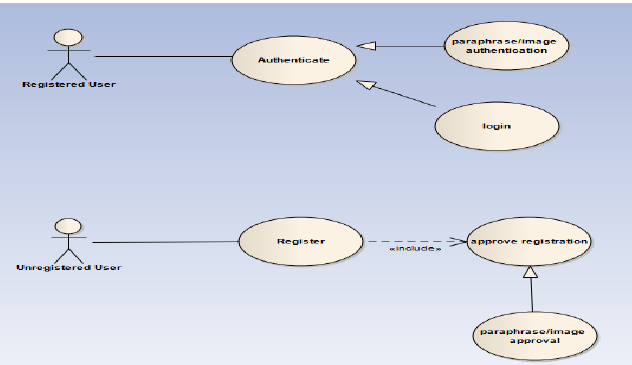
Figure 1: Proposed Model of MyBRS: Registration and Login Flow